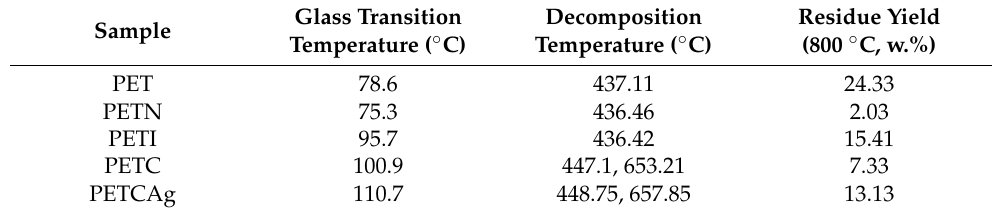
Figure 6. Silver quantification on PETCAg films by TGA under nitrogen flow.